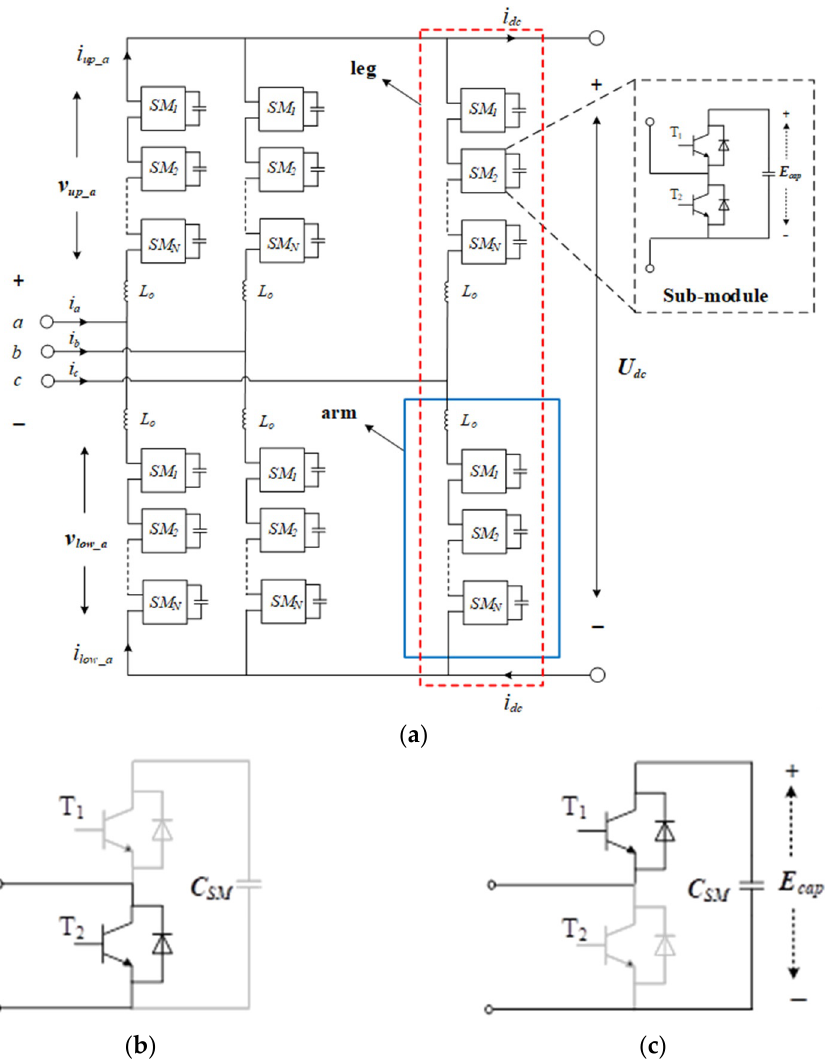
Figure 1. Modular multi-level converter (MMC) circuit diagram: ( a ) its topology; operation of a half-bridge sub-module under the normal condition of ( b ) zero voltage; ( c ) charge/discharge current path of C SM .